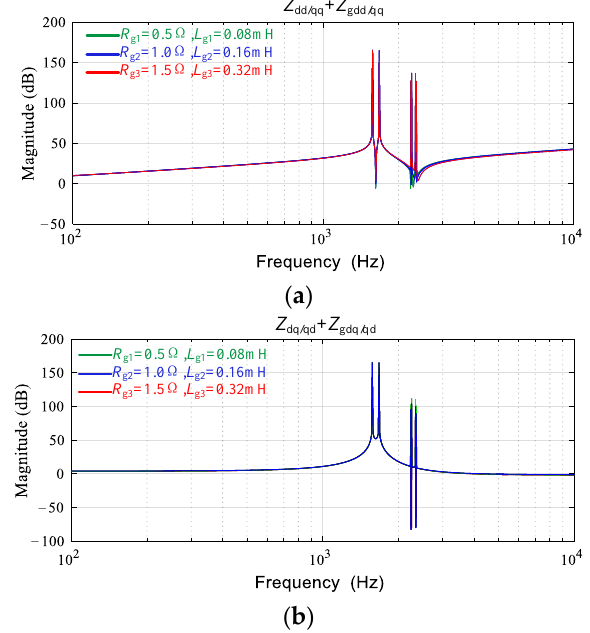
Figure 8. Impedance Bode plots under different parameters of the grid without an inner regulator. ( a ) Impedance characteristics on the main diagonal. ( b ) Impedance characteristics on the subdiagonal.